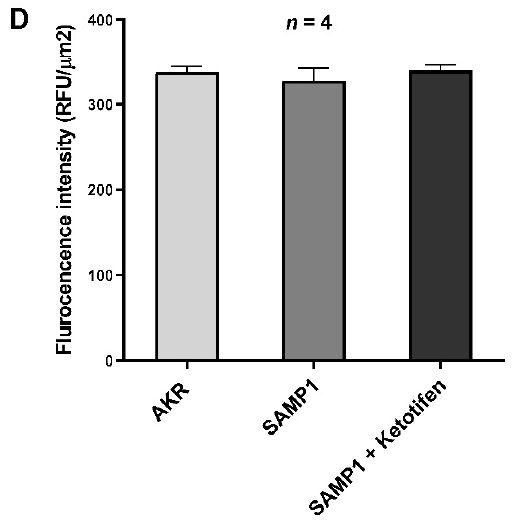
Figure 8. Immunofluorescence of DRA in small intestine of AKR, SAMP1 and ketotifen treated SAMP1 mice. Images captured at 20 × magnification. ( A ) DRA in AKR mouse intestine demonstrating its abundance in the BBM of villus cells lining the villus. ( B ) In SAMP1 mouse intestine demonstrating DRA in the BBM of villus cells lining the villus remained unaltered during chronic ileitis compared with AKR villus cells. ( C ) DRA in ketotifen treated SAMP1 mouse intestine demonstrating that DRA expression is unchanged in the BBM of villus cells. ( D ) Quantitation analysis showed that DRA expression was not altered in small intestine of AKR, SAMP1 and ketotifen treated SAMP1 mice.